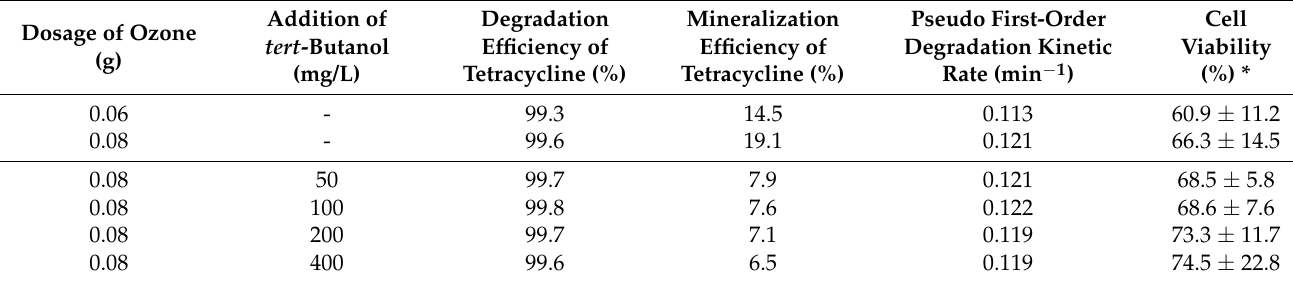
Table 3. Degradation and mineralization of tetracycline by ultrafine-bubble ozonation at different ozone dosages and tert -butanol additions.